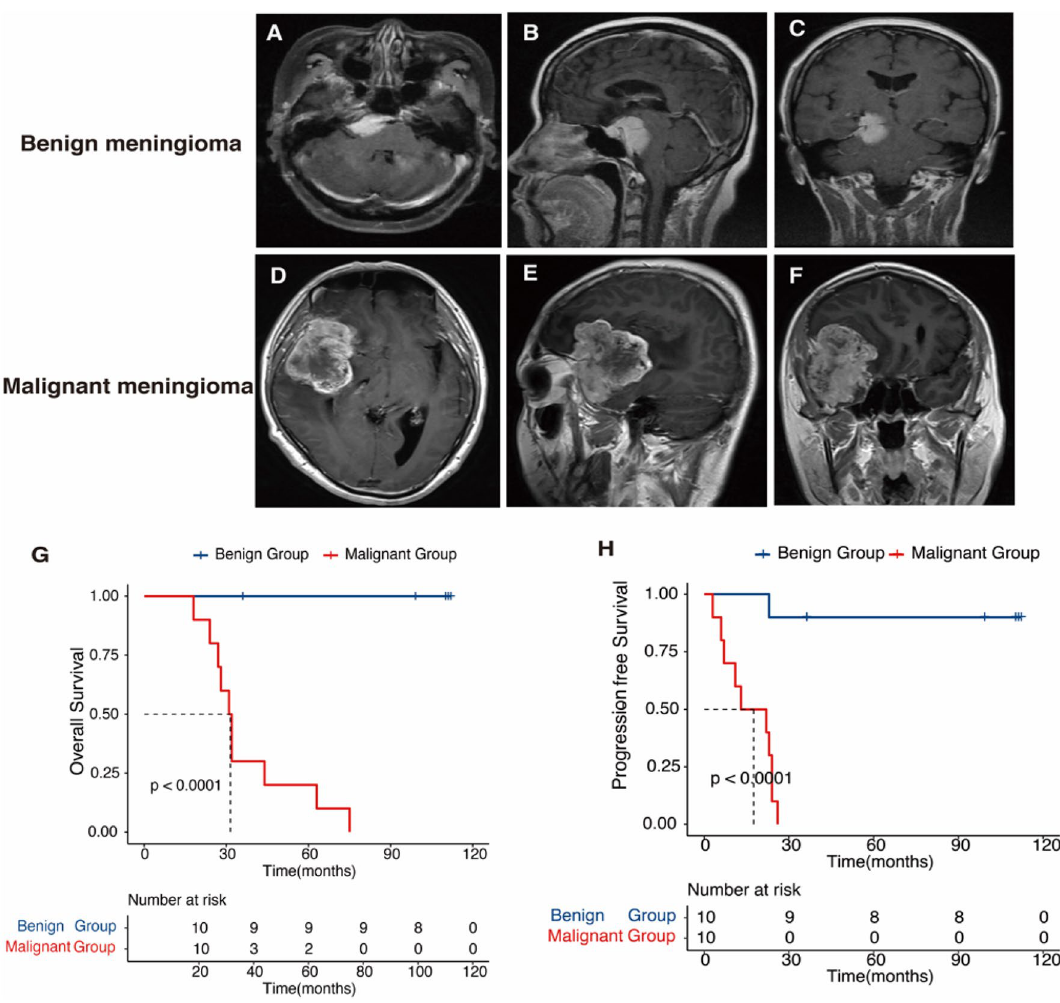
Figure 1. MRI of meningioma patients with benign progression and with malignant progression. ( A , B , C ) Same meningioma patient with WHO 1 pathology; ( D , E , F ) Same meningioma patient with WHO 3 pathology and the tumor penetrate the dura mater and invade into brain. Kaplan–Meier survival analysis of meningioma patients. ( G ) Meningioma patients with malignant progression have shorter overall survival time than patients with benign progression ( P < 0.0001); ( H ) Meningioma patients with malignant progression have shorter progression-free survival time than patients with benign progression ( P < 0.0001). Log-rank test was used as the